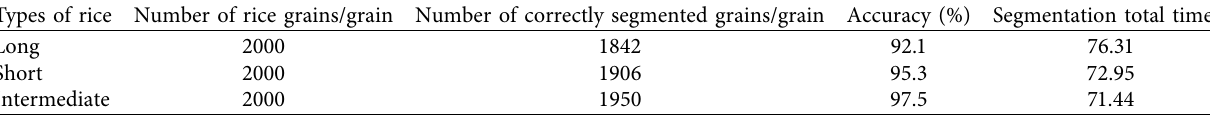
Table 5: The proposed algorithm segmentation